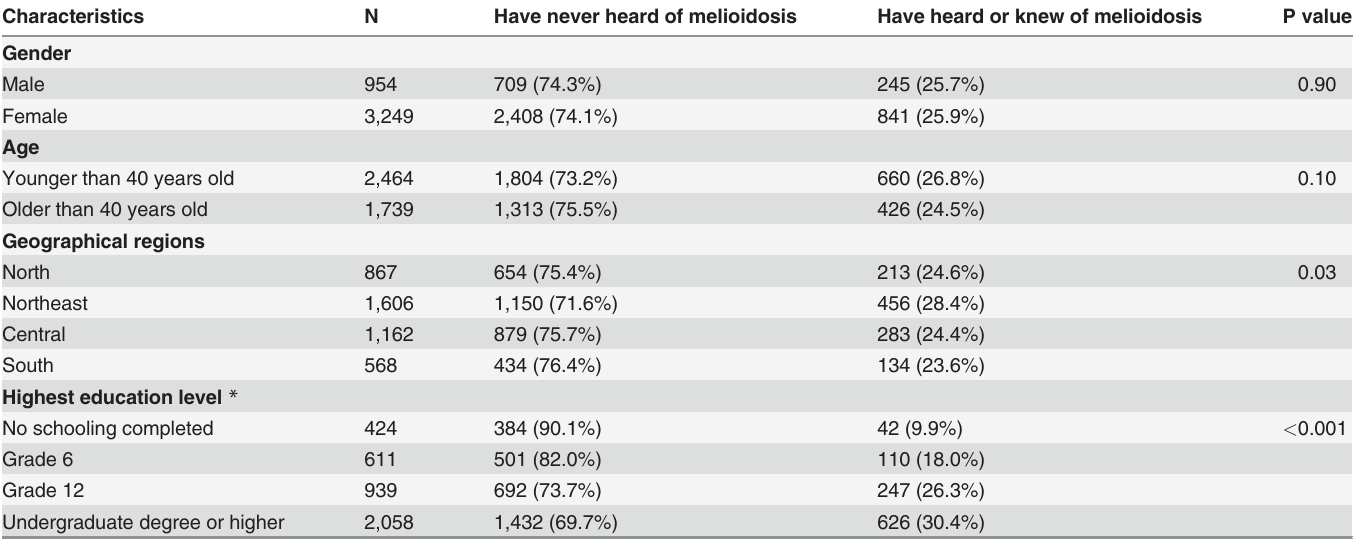
Table 2. Awareness of melioidosis in Thailand.